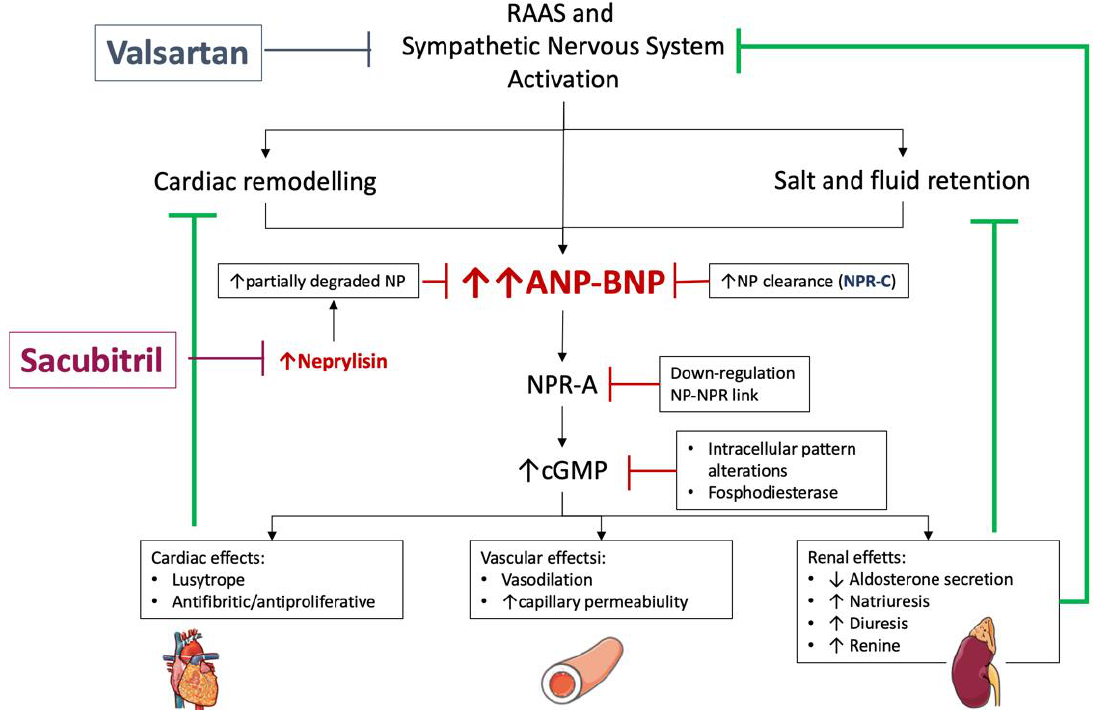
Figure 1. Effects of sacubitril/valsartan on the natriuretic peptide system. The inhibition of nepri- lysin by sacubitril increases the availability of active natriuretic peptides, which exert favorable ef- fects by interacting with natriuretic peptide receptors. Arrows indicates the increase ( ↑ ) or the de- crease ( ↓ ) of the different mentioned effects. ANP: atrial natriuretic peptide; BNP: brain natriuretic peptide; NP: natriuretic peptide; NPR-A: type A natriuretic peptide receptor; NPR-C: type C natri- uretic peptide receptor.